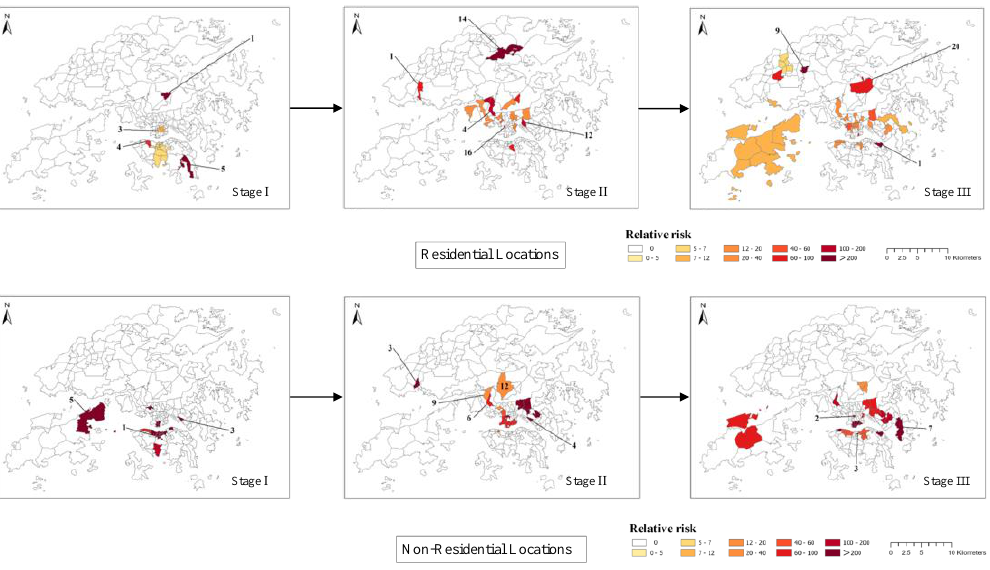
Figure 11 . Space – time clusters ’ evolution of different stages and locations. Figure 11. Space–time clusters’ evolution of different stages and